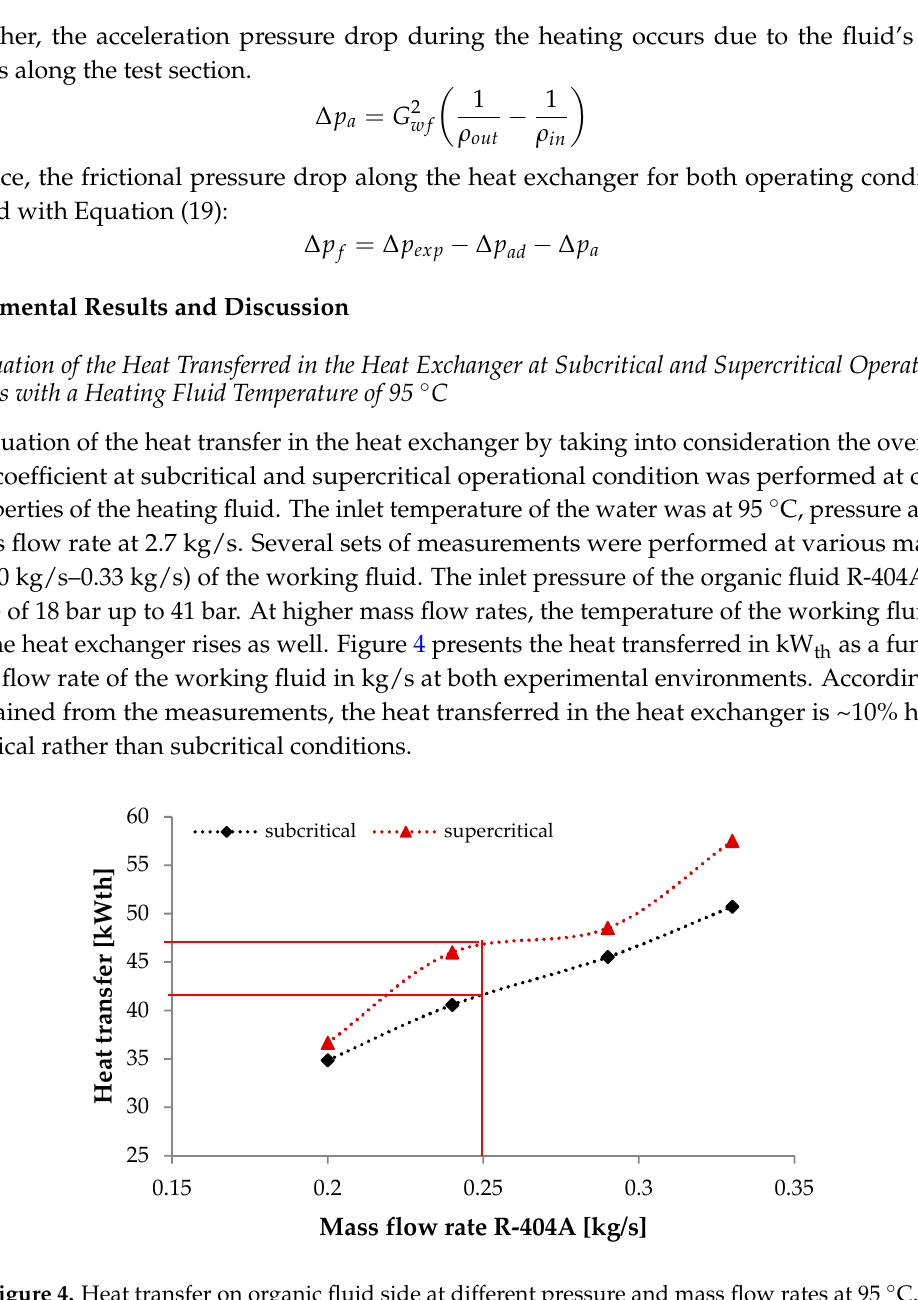
Figure 4. Heat transfer on organic fluid side at different pressure and mass flow rates at 95 °C.